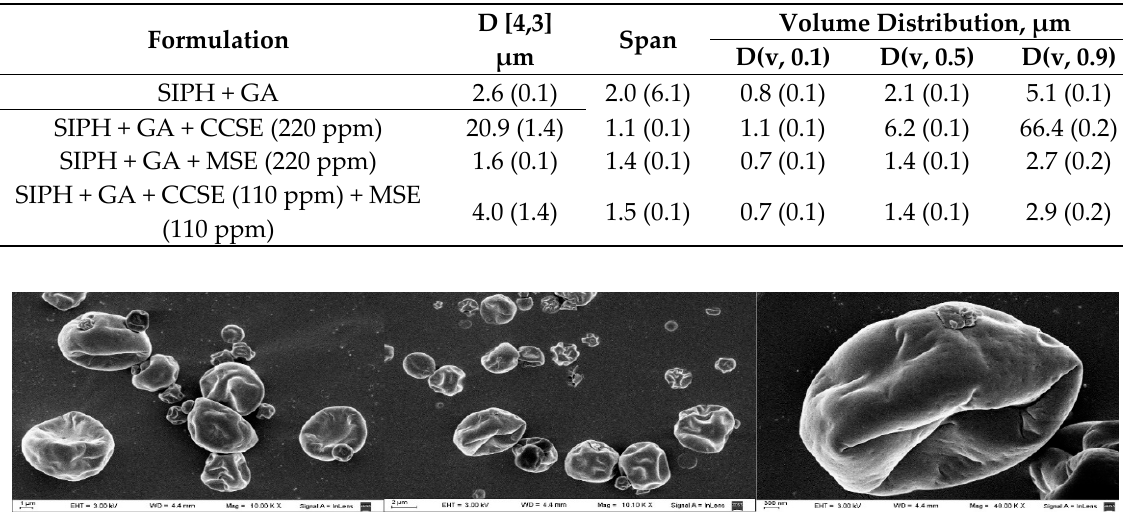
Table 2. D [4,3] values obtained from sacha inchi, P. huayllabambana oil microencapsulated (SIPH).